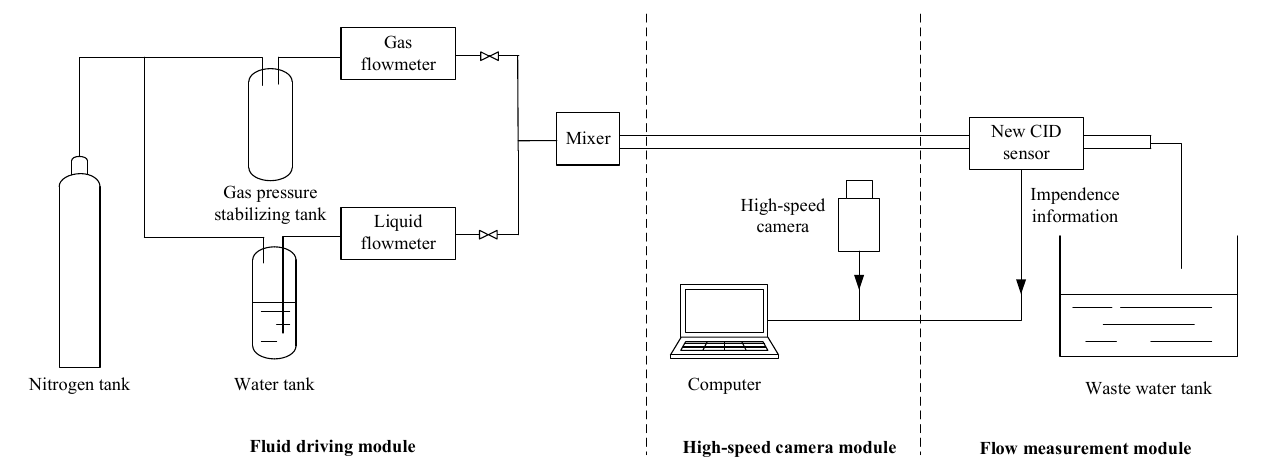
Figure 3. Diagram of the experimental setup.